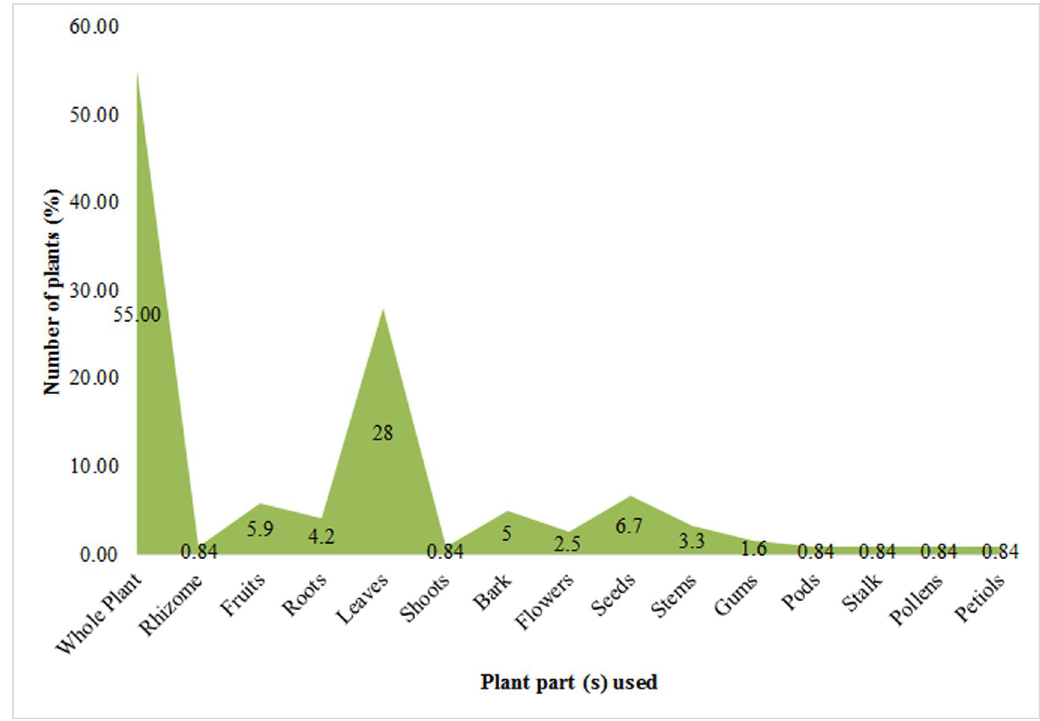
Fig 4. The percentage of different parts of plants used for ethnomedicine.